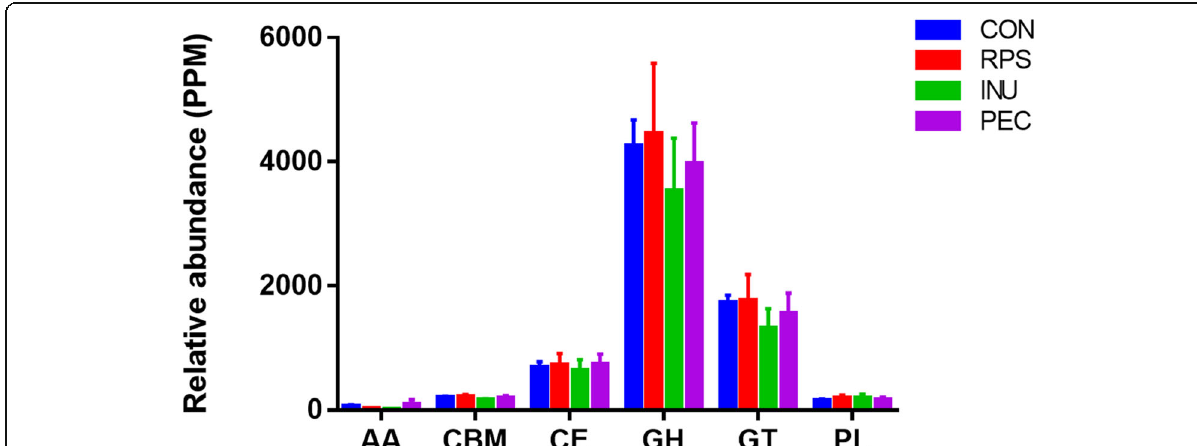
Fig. 5 Distribution of CAZyme at the class level in each group. AA, auxiliary activities; CBM, carbohydrate-binding modules; CE, carbohydrate esterases; GH, glycoside hydrolases; GT, glycosyl transferases; PL, polysaccharide lyases. CON, control diet; RPS, raw potato starch-enriched diet; INU, inulin-enriched diet; PEC, pectin-enriched